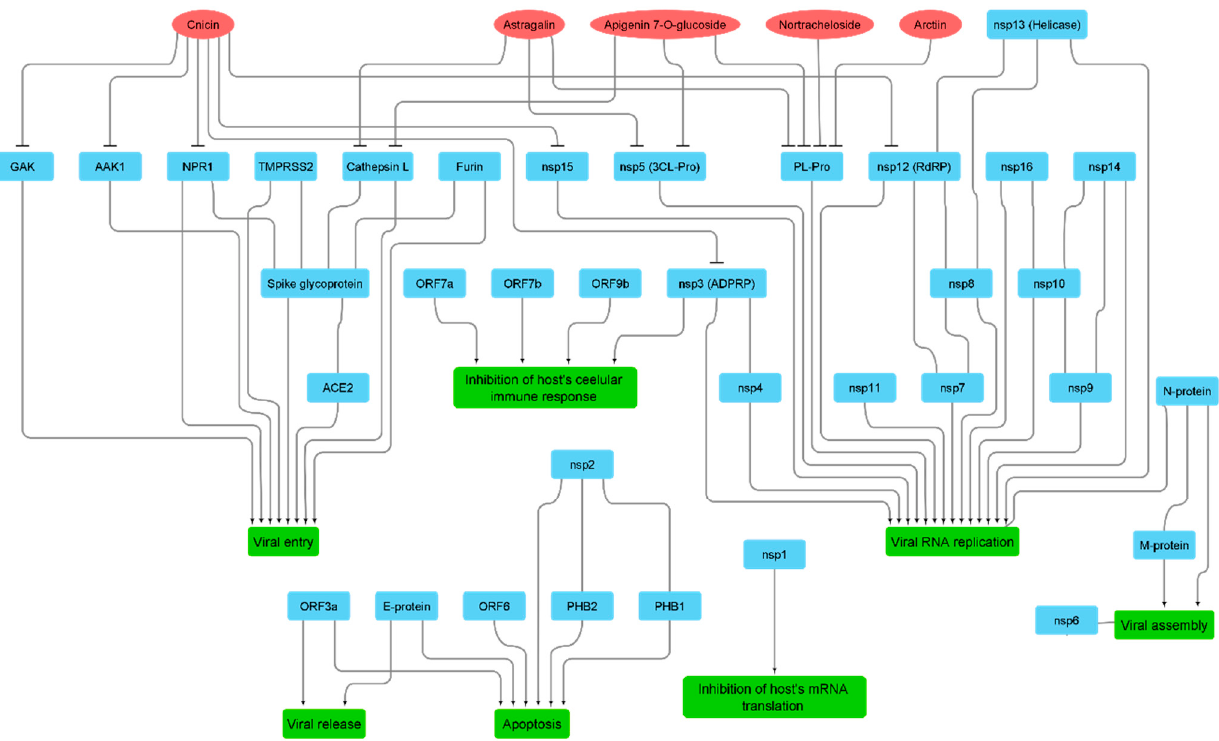
Figure 4. A comprehensive interaction network summarizes our in silico outcomes. Red nodes represent CBE-derived compounds that were predicted to bind with one or more COVID-19-derived proteins. Blue nodes represent all currently available viral and host proteins. Green nodes represent the biological function linked to each group of COVID-19-derived proteins. Black edges represent the interactions between compounds and target proteins, between proteins, and between each group of proteins and their biological function.